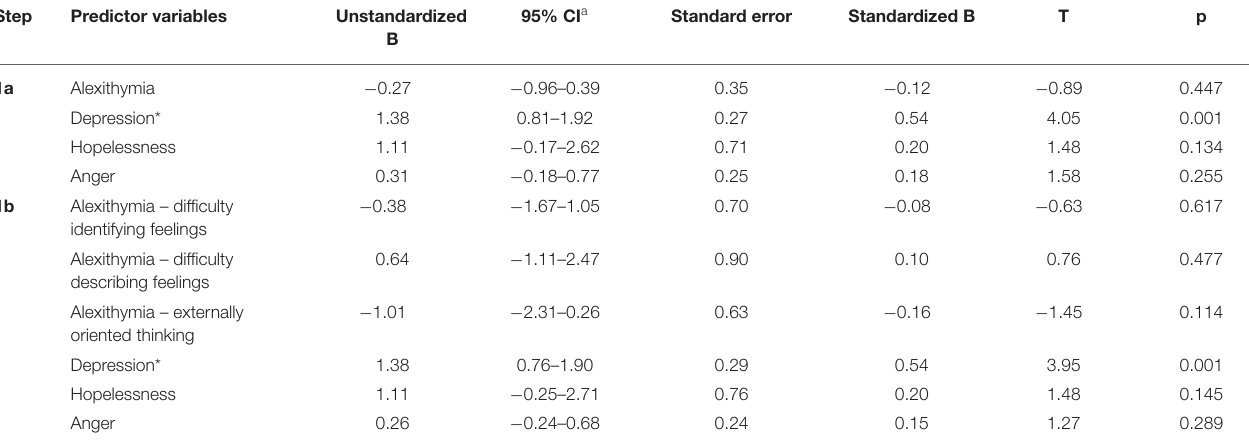
TABLE 2 | Suicide ideation hierarchical multiple regression ( N = 60).